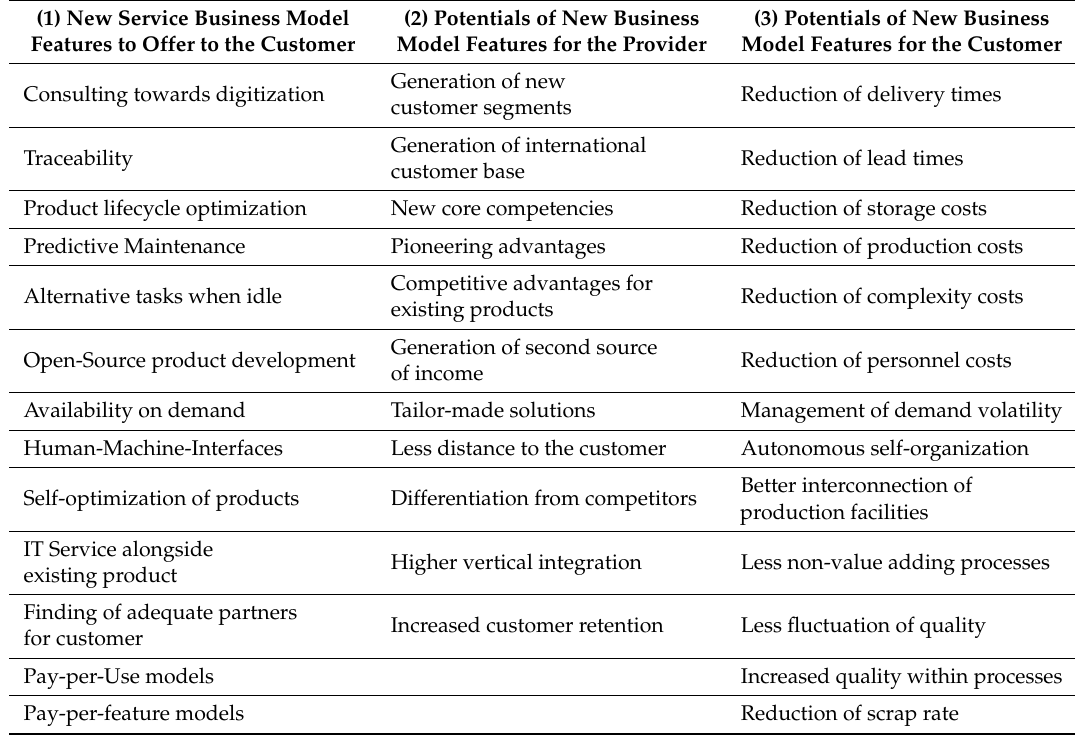
Table 1. Overview of survey